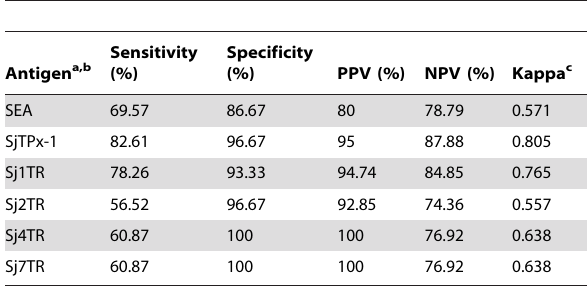
Table 2. Statistical analysis of the ELISA results of SEA and the recombinant